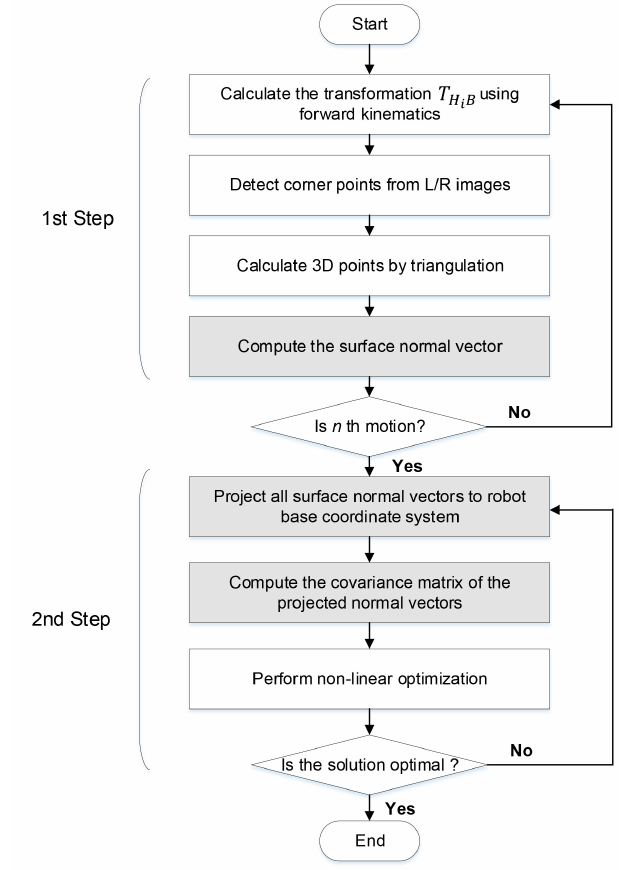
Figure 5. Flowchart of the proposed method. The grayed blocks denote the new steps in the proposed method compared to the previous